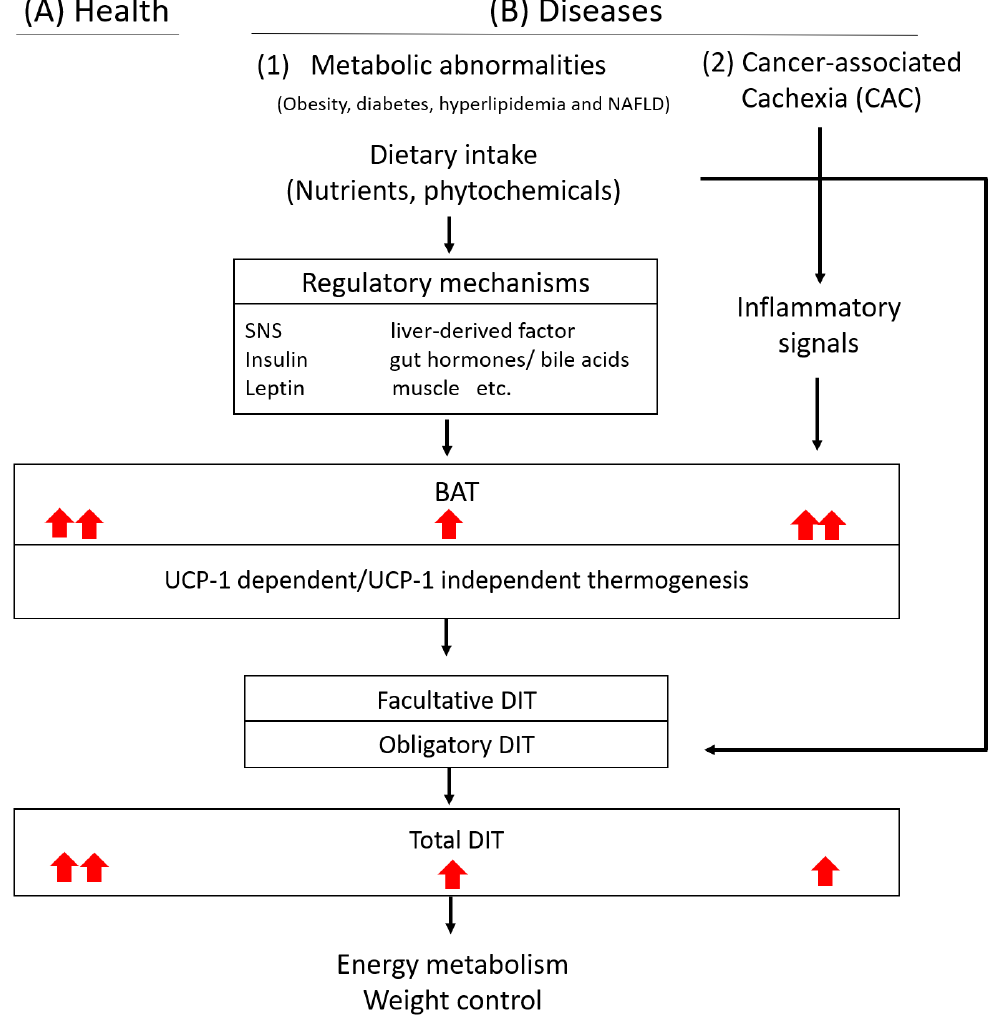
Figure 1. The role and regulatory mechanism of BAT activation in DIT in health and diseases. ( A ) Under healthy condition, dietary intake could promote BAT activation (facultative DIT) and total DIT to facilitate whole-body energy metabolism. ( B ) Under disease conditions: (1) Metabolic abnormalities such as obesity, diabetes, hyperlipidemia and NAFLD, dietary intake-induced BAT activation, and total DIT will be attenuated and might subsequently, affect whole-body energy balance and weight control. (2) Cancer-associated Cachexia (CAC) is characterized by systemic inflammation, which could enhance thermogenesis in BAT and increase systemic energy expenditure. However, low DIT were noted in the development of cancer cachexia.